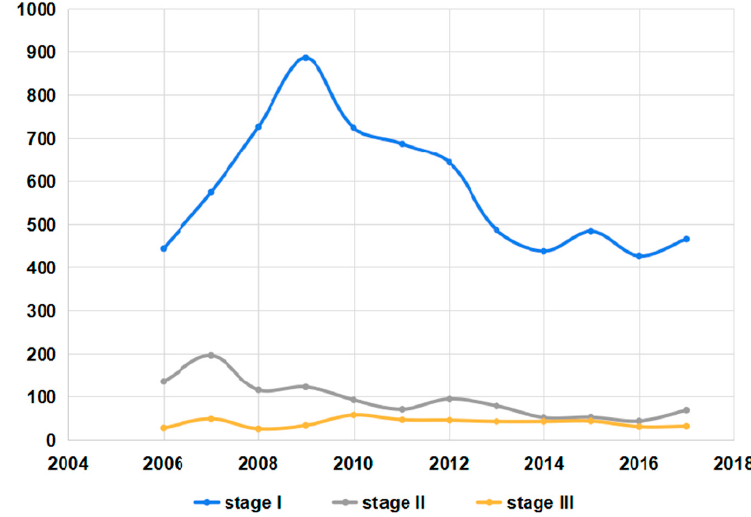
Figure 2. The changes in the stages of pneumoconiosis cases reported from 2006 to 2017.